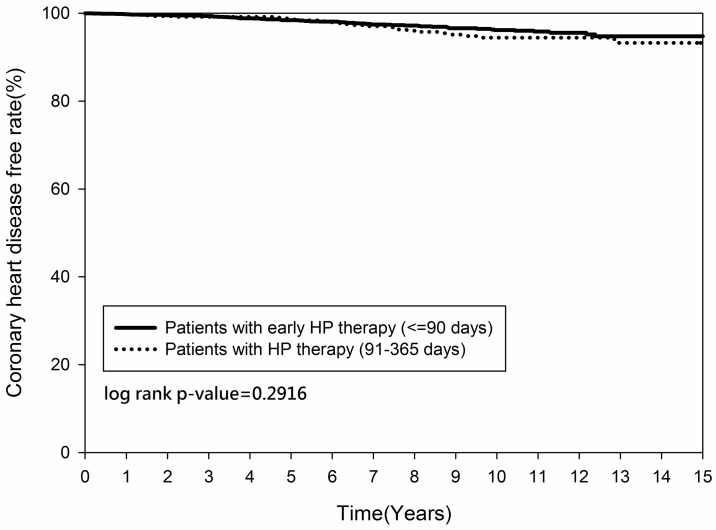
Kaplan-Meier curve for coronary heart disease rate between patients with and without Helicobacter pylori therapy, by time of initiation.